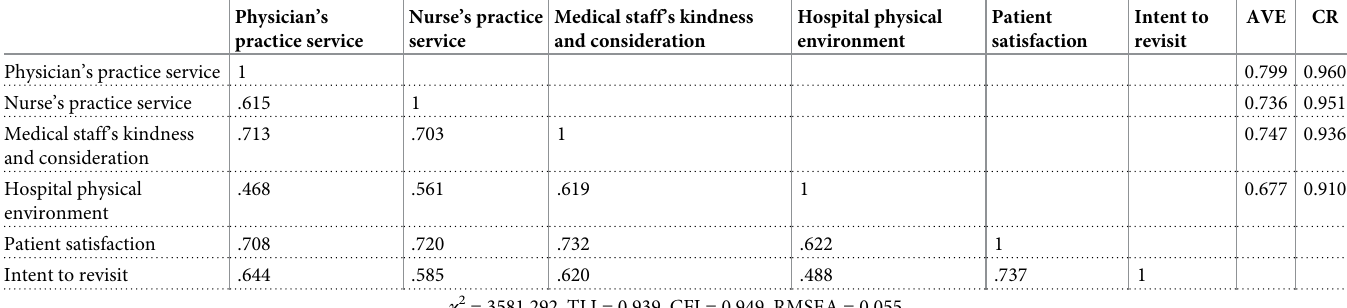
Table 3. Correlation matrix (inpatient).